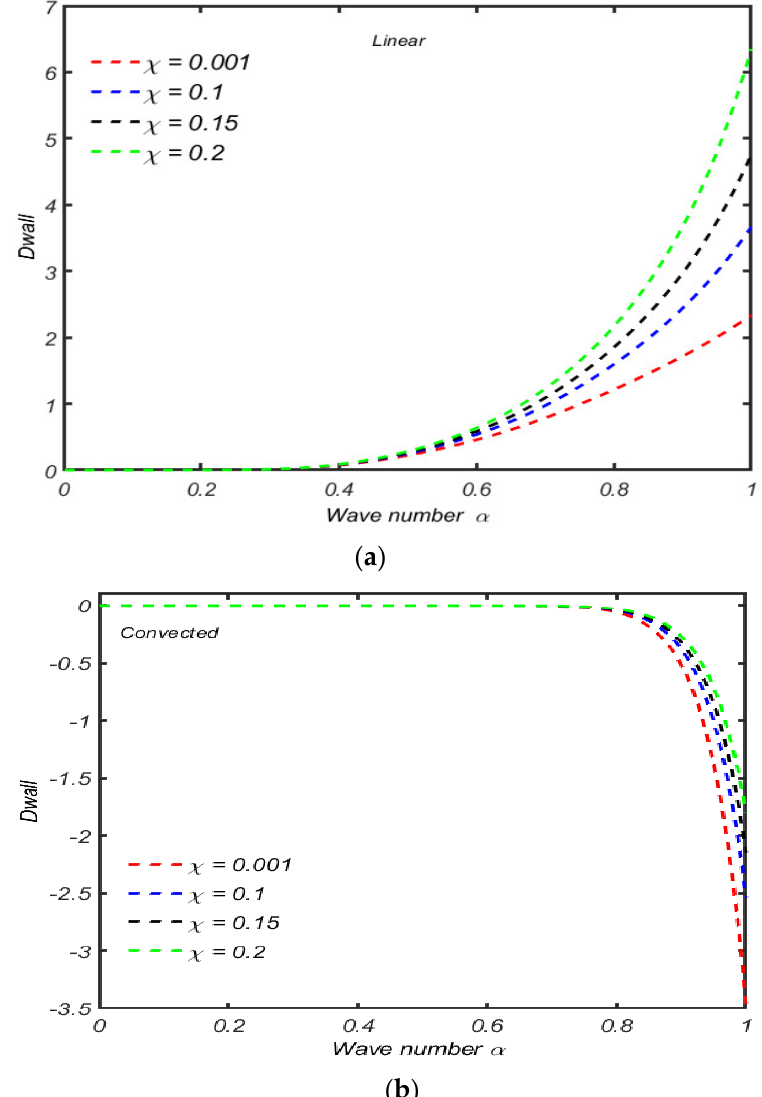
Figure 5. ( a ) Variation of D wall against α for χ with R = 10, λ 1 = 1. ( b ) Variation of D wall against α for χ when other parameters are R = 10, λ 1 =